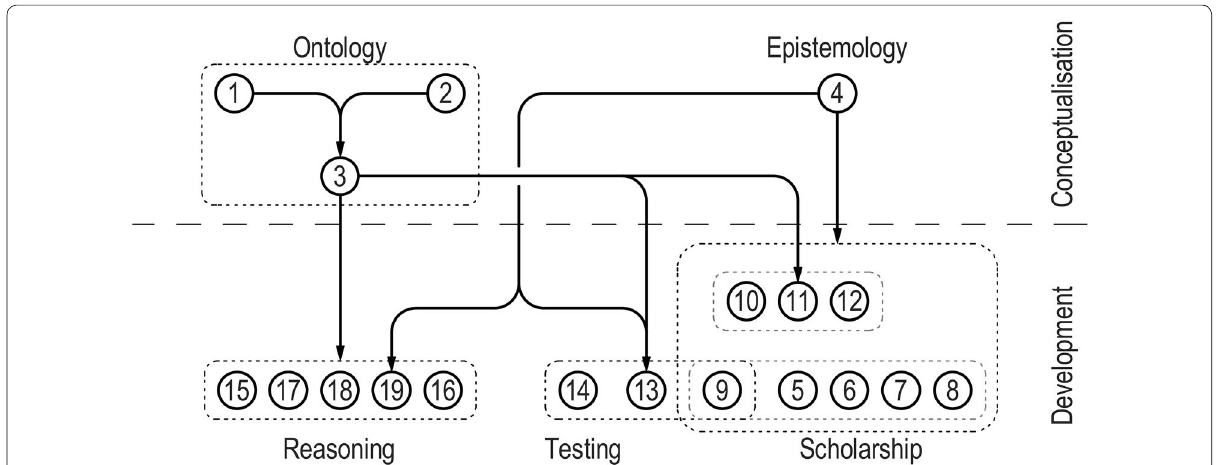
Fig. 2 Criticism connections and groupings of Alexander’s second theory of architecture: development and documentation. Numbers correspond to criticism numbers in text and tables, dotted lines indicate groups and sub-groups of criticisms, arrows point from antecedent criticisms to sec- ondary criticisms or groups of